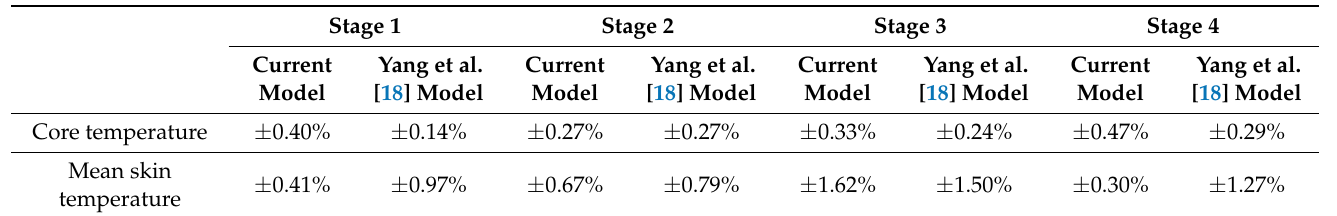
Table 3. Relative error between the predicted results of the two models and the experimental